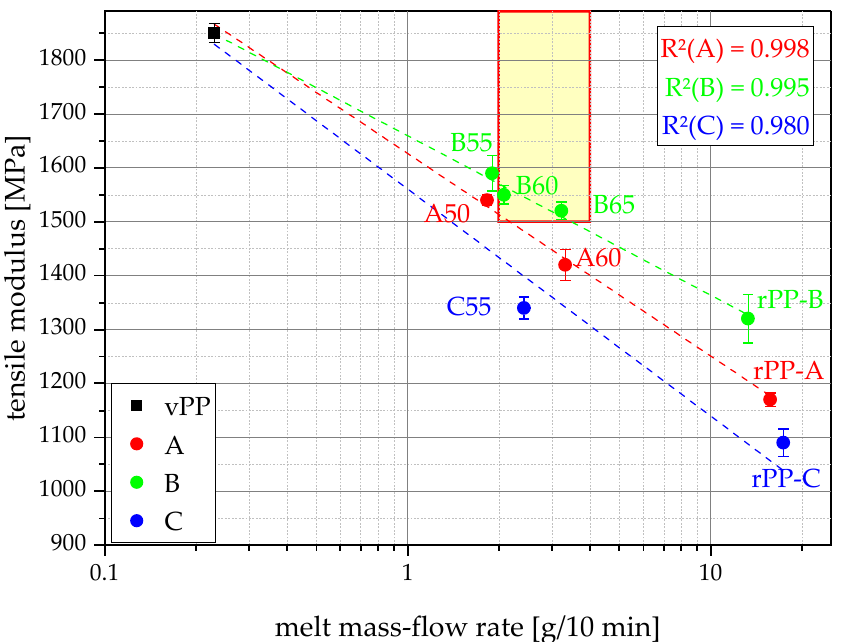
Figure 8. Correlation between MFR and tensile modulus for all materials. The desired property window (MFR: 2 – 4 g/10 min & tensile modulus above 1500 MPa) is highlighted in yellow.